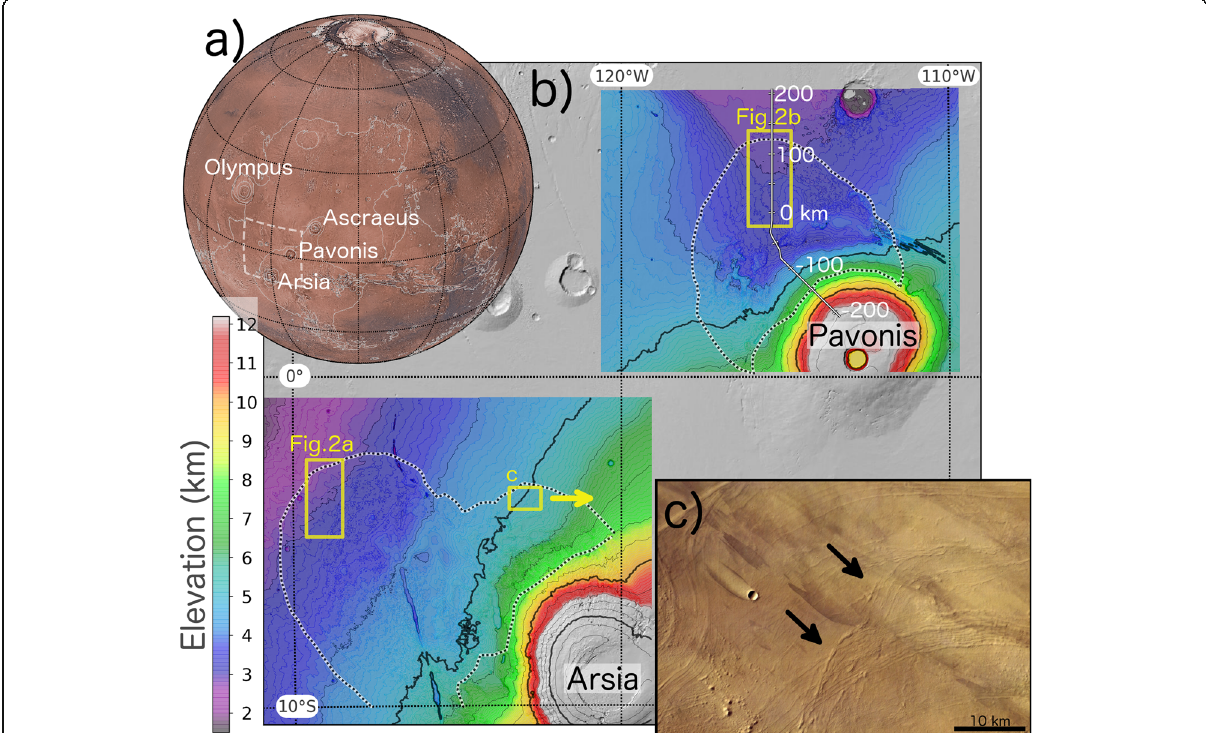
Fig. 1 Topography of the Arsia and Pavonis FSDs. a A true color image mosaic from Viking data of the western hemisphere of Mars. b Detailed elevation (colored regions) of the FSDs (outlined with black/white dotted line) indicate rougher topography within the FSDs and presence of volcanic rifts at Arsia. White line with labeled distances gives the location of the flowline used in numerical model. c HRSC image of the outer margin of the Arsia FSD where the intersection of moraine-like ridges (arrows) indicates that glacial activity was not capable of eroding previous ridges during subsequent glacial